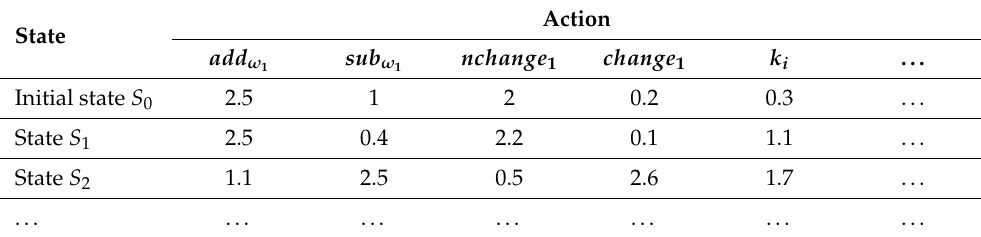
Table 3. State–action